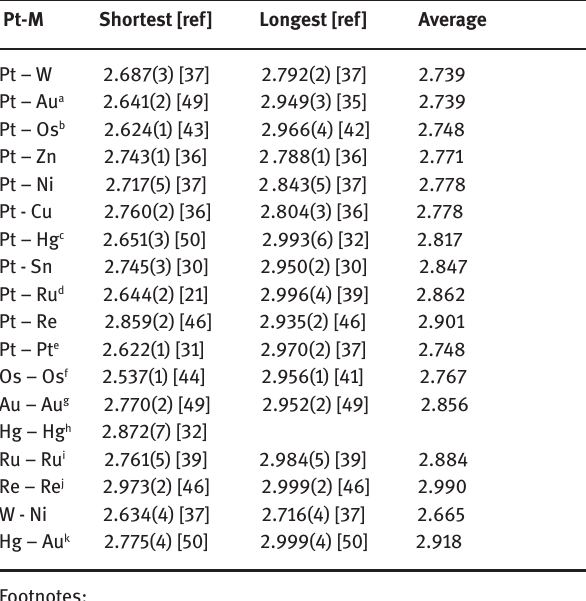
Table 4: Summary of the Pt-M, M-M and M-M´ bond distances (< 3.0 Å) in heterooctanuclear platinum